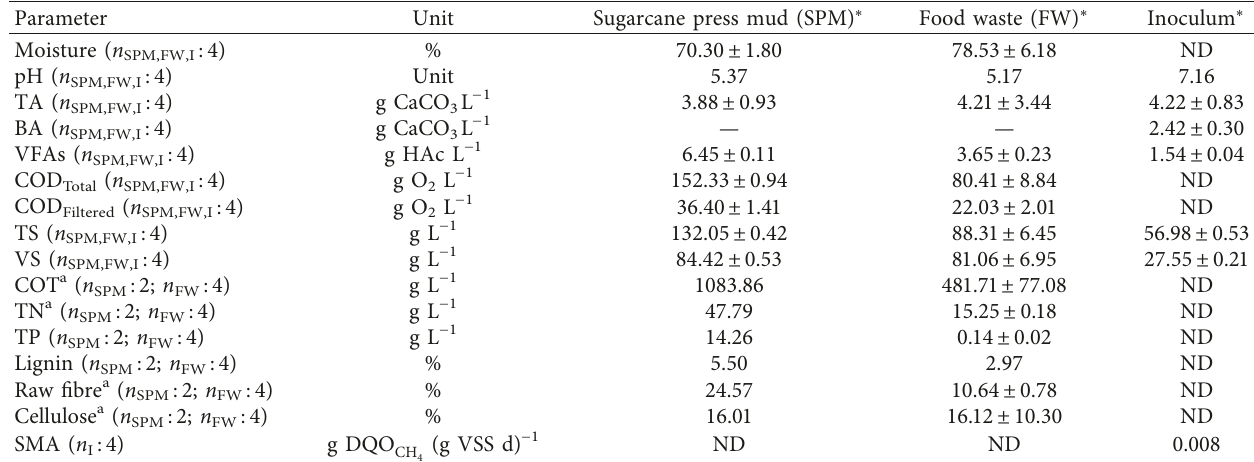
Table 2: Physicochemical characterization of substrates and